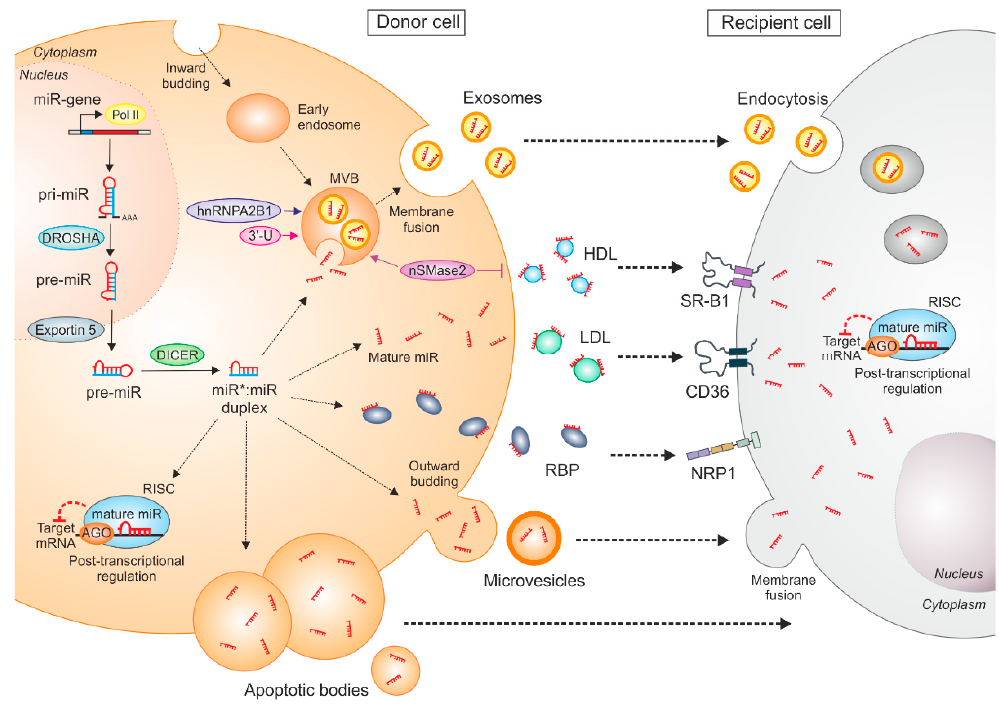
Figure 1. Mechanisms of miR synthesis, transfer, and intercellular communication. MiRs are transcribed by RNA polymerase II (Pol II) into primary-miRs (pri-miR), which are further processed by the DROSHA complex. The arising precursor miR (pre-miR) is exported to the cytoplasm by exportin 5 and cleaved by DICER to form a double-stranded miR:miR duplex. The mature miR is loaded onto Argonaute proteins (AGO), which together with other proteins forms the RNA-induced silencing complex (RISC). This complex binds to the 3 (cid:48) -untranslated region (UTR) of mRNA targets. MiRs can be exported from donor cells and taken up by recipient cells, where they repress target gene expression. Several miR carriers exist, such as extracellular vesicles (exosomes, microvesicles, apoptotic bodies), RNA-binding proteins (RBP), or high / low-density lipoproteins (HDL / LDL). MiRs can be loaded into multivesicular bodies (MVB), which are generated via early endosomal inward budding of the plasma membrane. Upon fusion of the MVBs with the plasma membrane, exosomal miRs are released into the extraluminal space. Amongst other mechanisms, the sorting of miRs into exosomes is regulated by sumoylated heterogeneous nuclear ribonucleoprotein A2 / b1 (hnRNPA2B1) and miR 3 (cid:48) end base modifications (3 (cid:48) U). Moreover, the export of miRs via exosomes is neutral sphingomyelinase 2 (nSMase2)-dependent, which, on the other hand, blocks HDL-miR release. Exosomal miRs can be taken up by recipient cells by endocytosis or via microvesicles, which are generated by outward budding of the plasma membrane of the donor cells. Those microvesicles release their miR cargo by fusion with the plasma membrane of the recipient cells. Apoptotic bodies containing miRs are generated upon cell injury or death and are phagocytosed. HDL-miR complexes can be taken up by recipient cells by scavenger receptor B1 (SR-B1), while the uptake of LDL-miR is mediated by CD36. MiRs can be transferred by RBPs, such as AGO2 or nucleophosmin, which can be taken up by recipient cells via neuropilin-1 (NRP1).